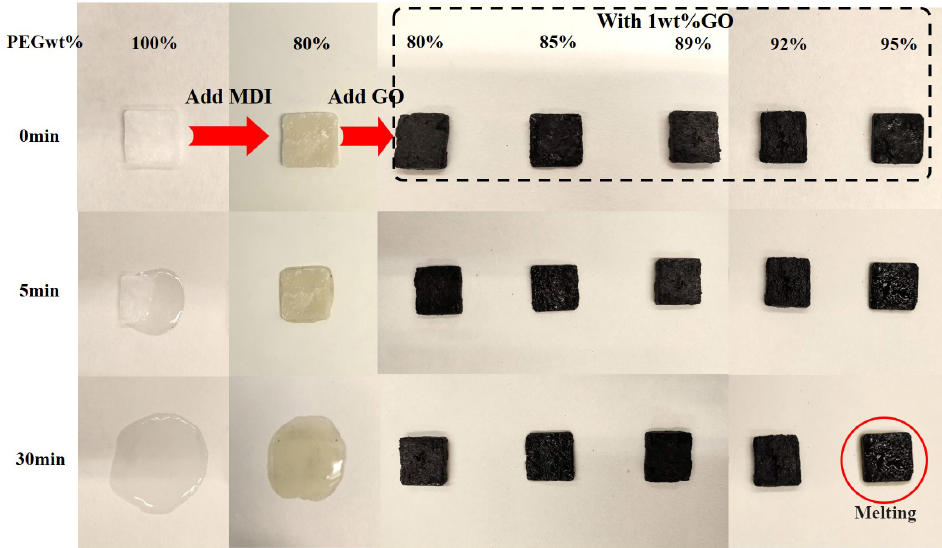
Figure 5. Digital images of PEG, PU and PU/GO at 80 °C for 30 min .